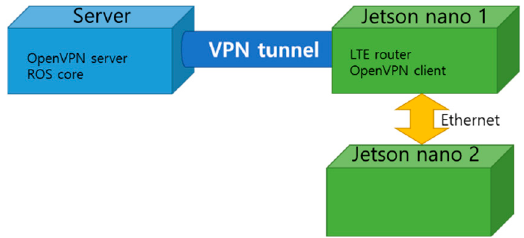
Figure 9. Virtural private network.